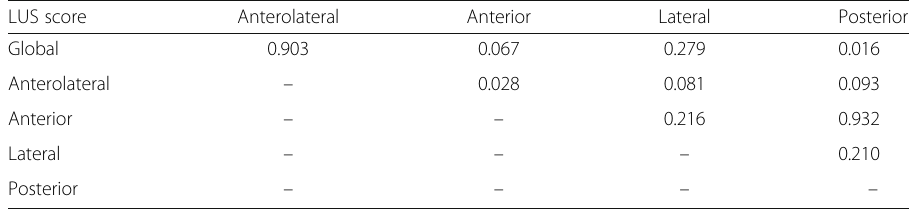
Table 3 Comparisons between the areas under the ROC using the De Long test LUS score Anterolateral Anterior Lateral Posterior Global 0.903 Anterolateral – Anterior – – – – – Posterior – – – –